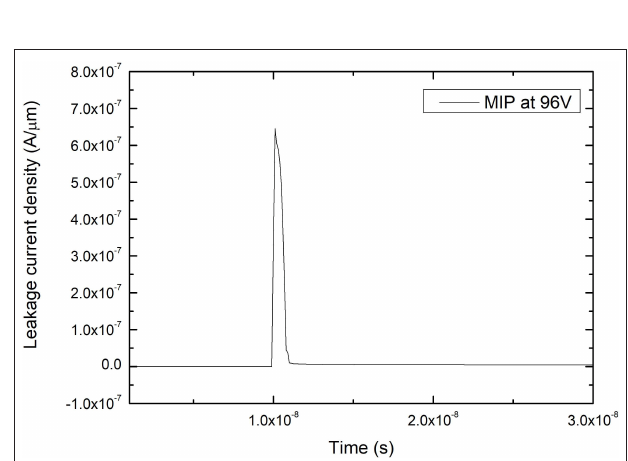
FIGURE 7 | MIP strike within the 12 µ m thick a-Si:H substrate at t 0 =10 ns under an applied bias of 96 V . This result takes into account the time sensitive behavior of the leakage current. The integral of the transient response is used to assess the charge collection associated with the MIP